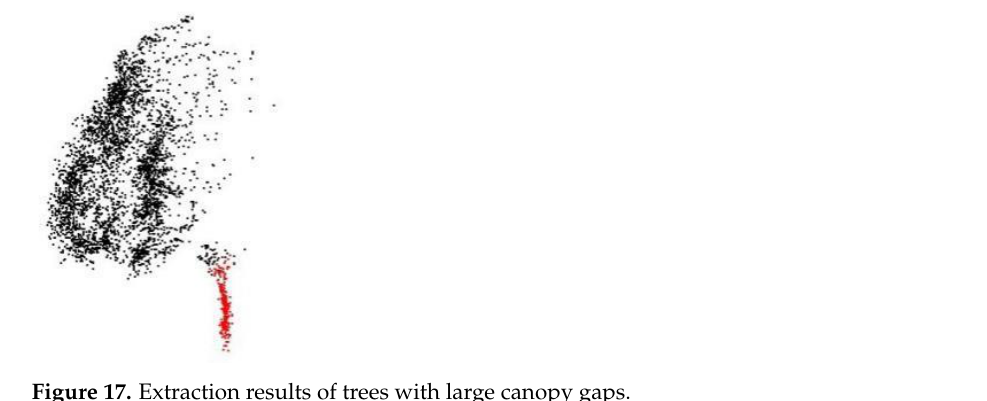
Figure 17. Extraction results of trees with large canopy gaps.